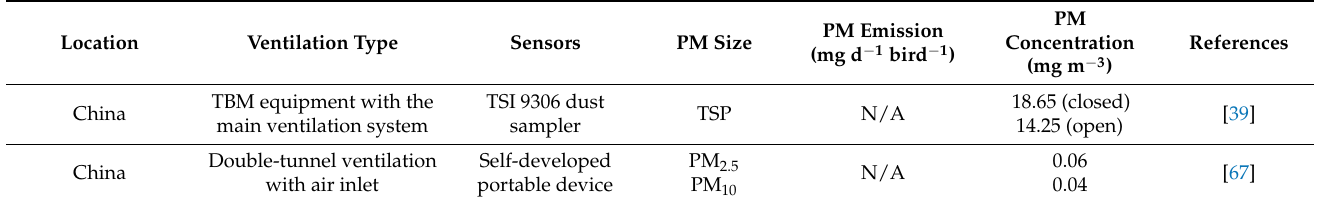
Table 5. Emission of PM due to various ventilation systems used in the housing